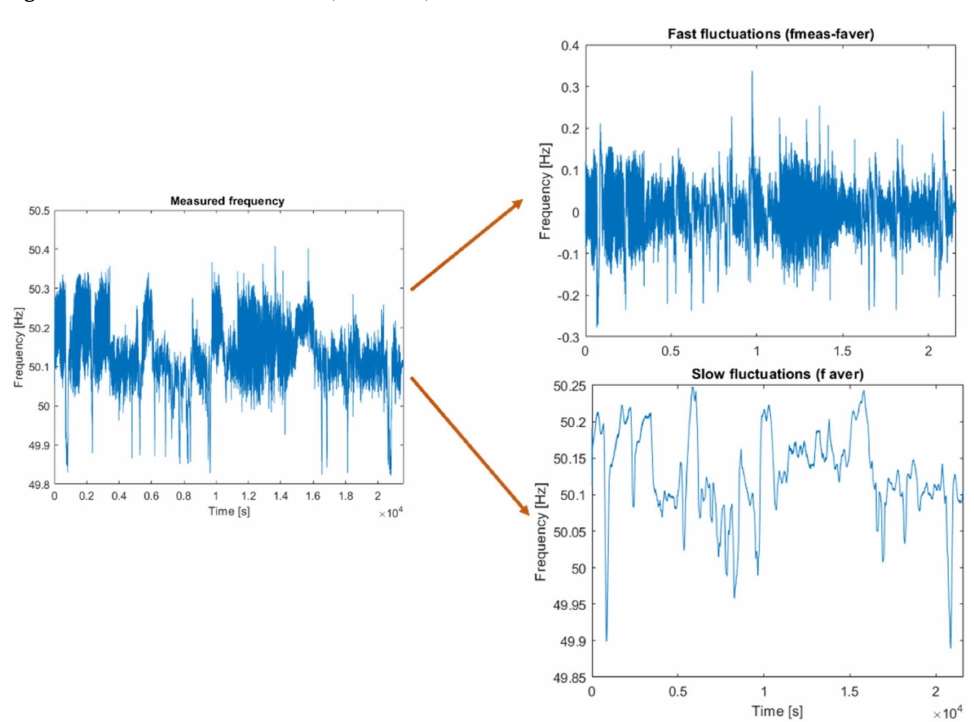
Figure 14. The decomposition of the frequency trend into fast and slow